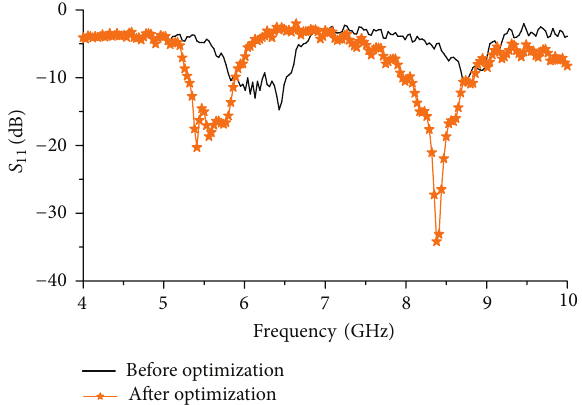
Figure 12: Measured 𝑆 11 response of the